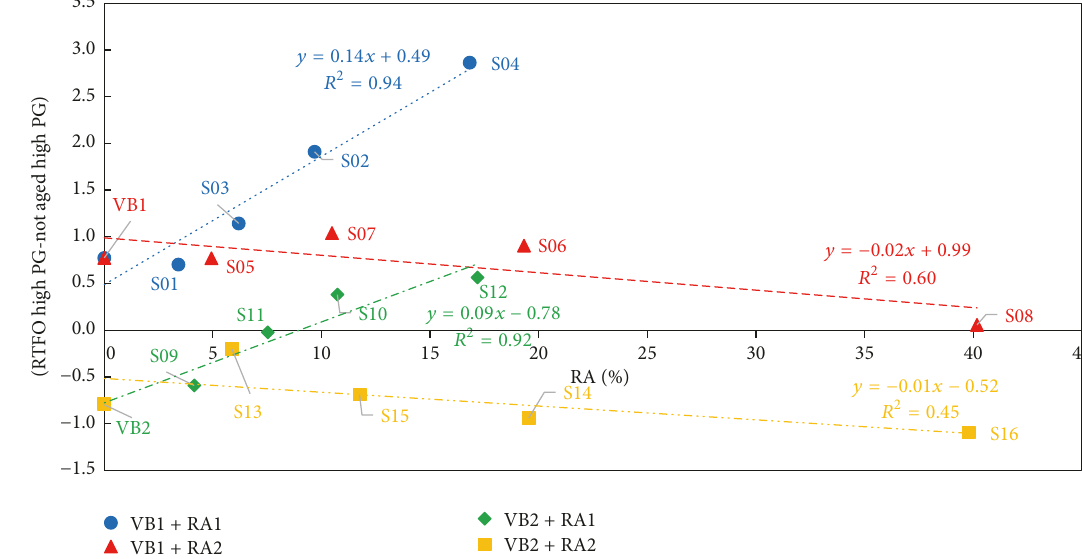
Figure 4: Change in the high PG by RTFO (RTFO PG, not aged PG).